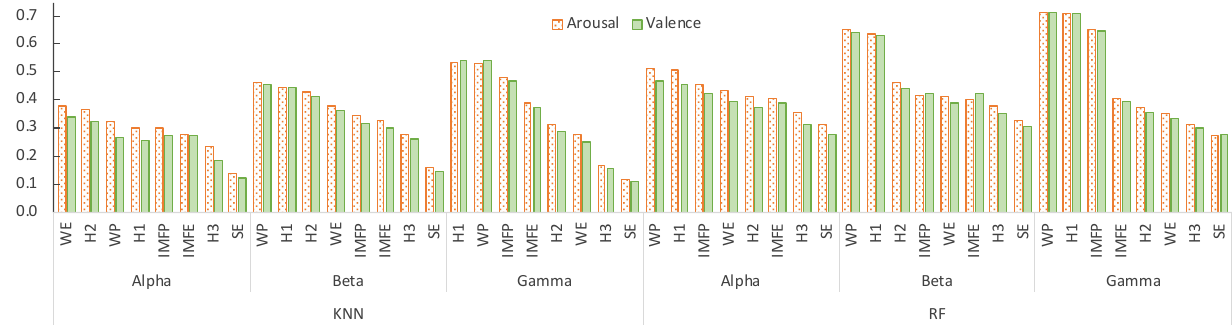
Figure 4. PCC values when each of the features per wave were used individually for predicting arousal and valence values. (best seen in